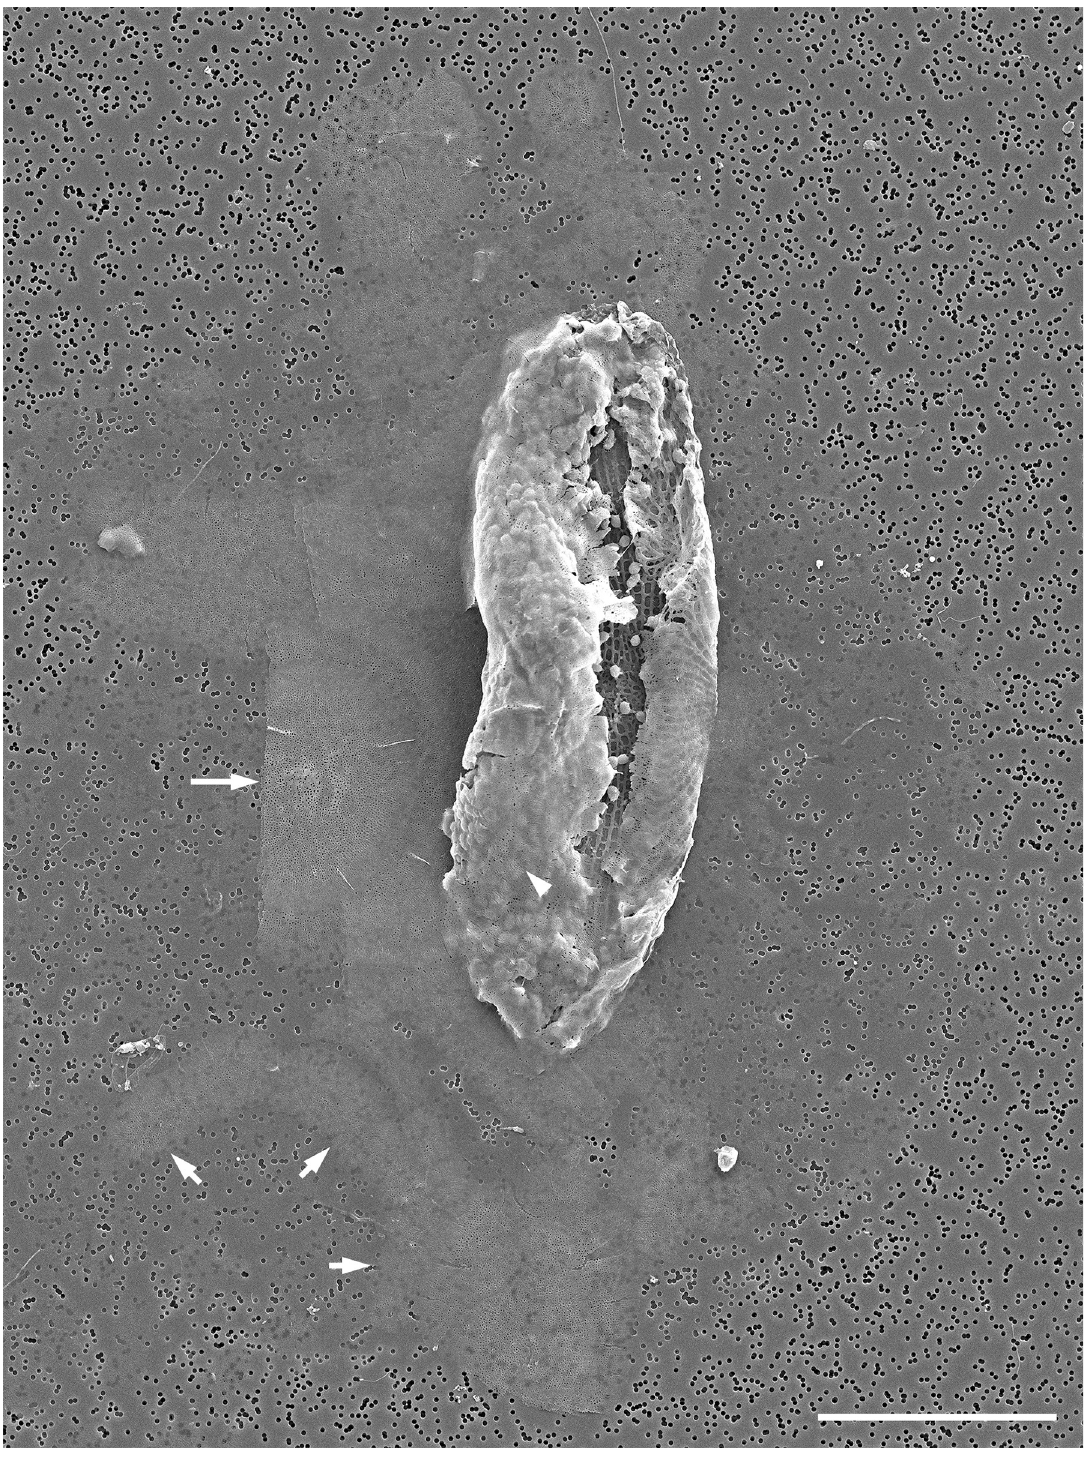
Fig 11. Partially disarticulated, nearly mature auxospore (SEM, acid cleaned specimen). Mature auxospore harboring basal silica layer of the initial epivalve (right side). Note deepest layers of auxospore wall have been exposed, showing TP (primary band indicated by long arrow), one of the LP bands (arrowhead) and subapical rings of TP bands (short arrows). Scale bar: 50 μ m.